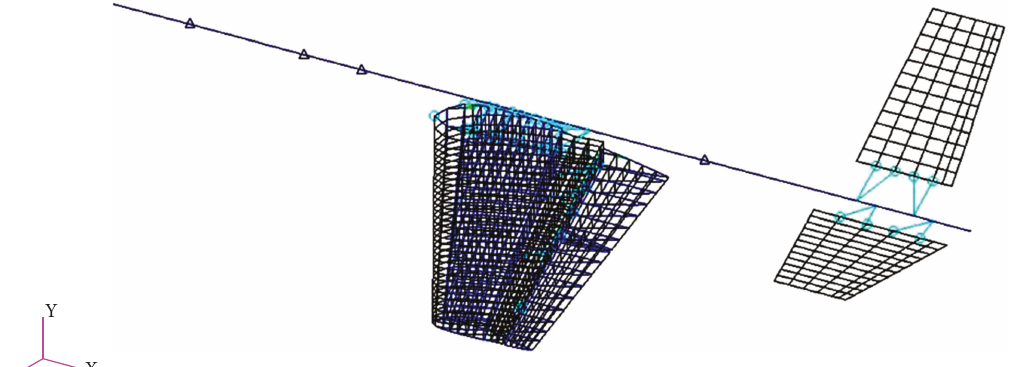
Figure 14: FEM of the wing and tails.